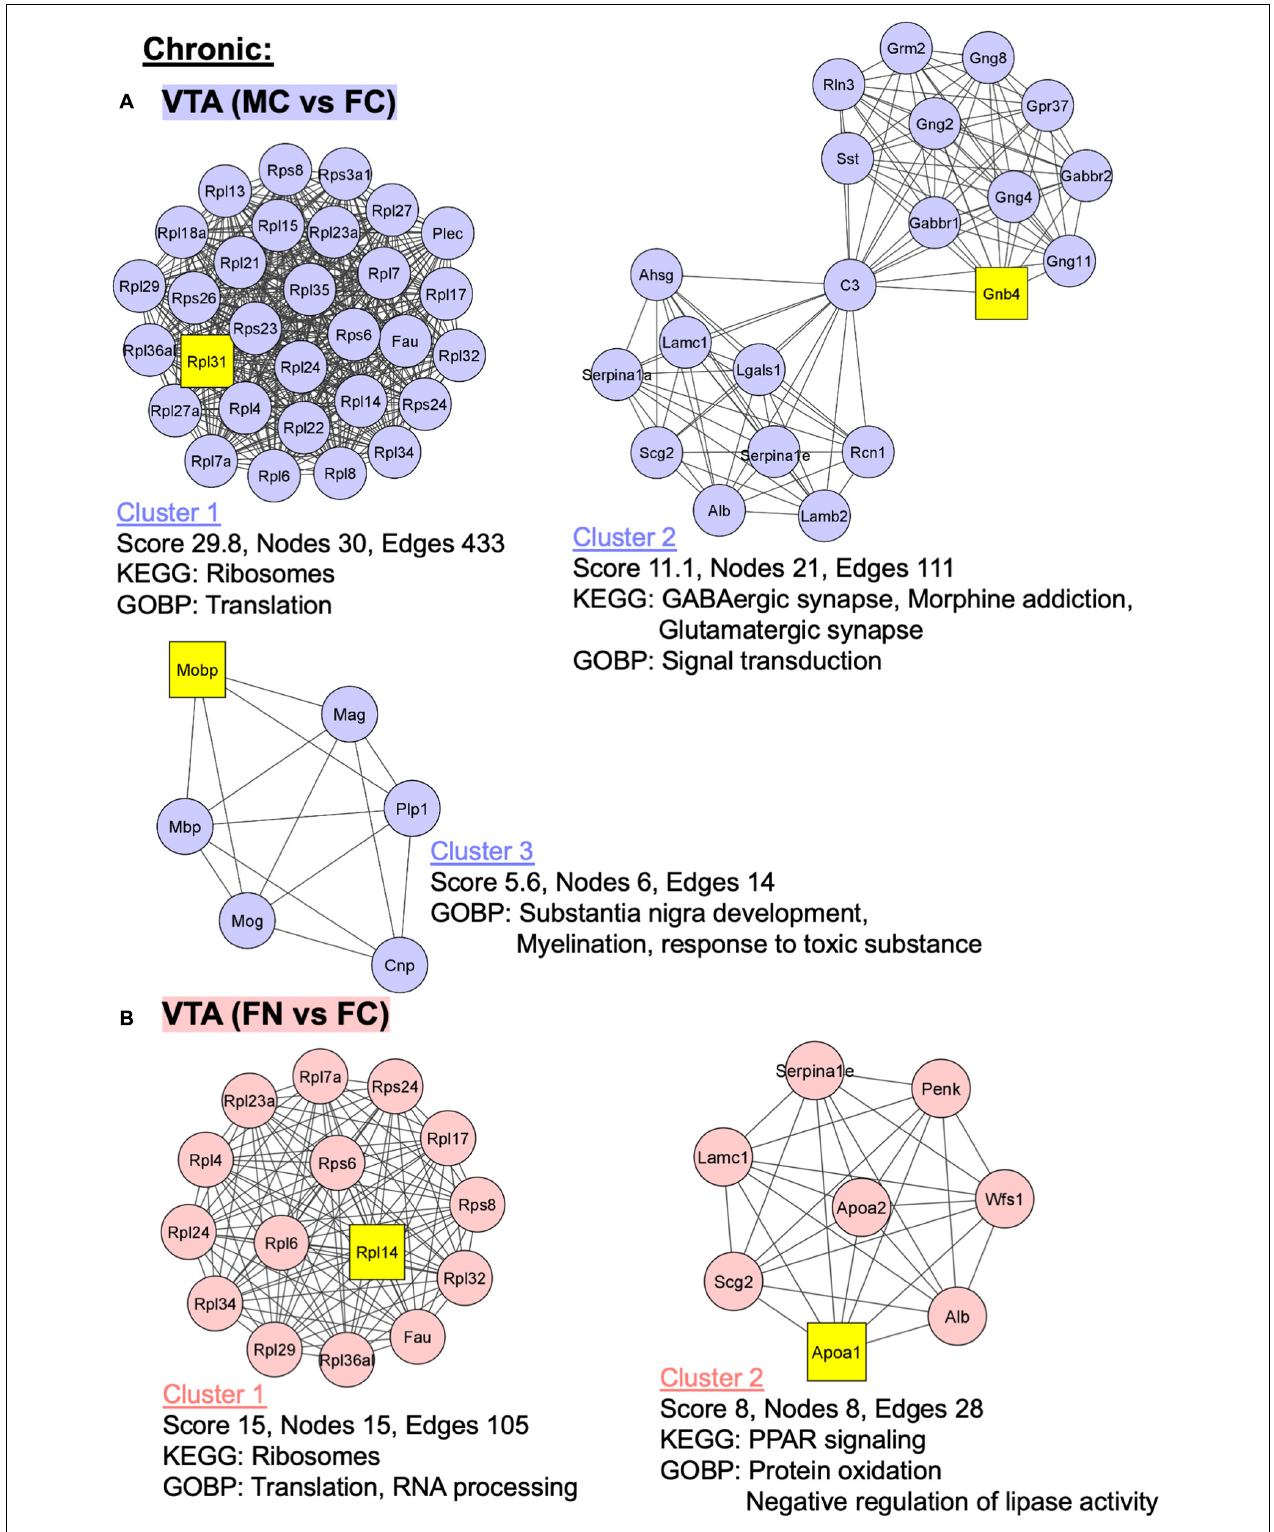
FIGURE 7 | PPI network analysis of differentially expressed proteins with and without chronic nicotine and withdrawal. PPI networks were constructed as described for Figure 6 . (A) The top three clusters are shown for MC vs. FC in the VTA of C57BL/6J mice used for chronic nicotine administration. (B) Two clusters were identified for FN vs. FC in the VTA after chronic nicotine administration and